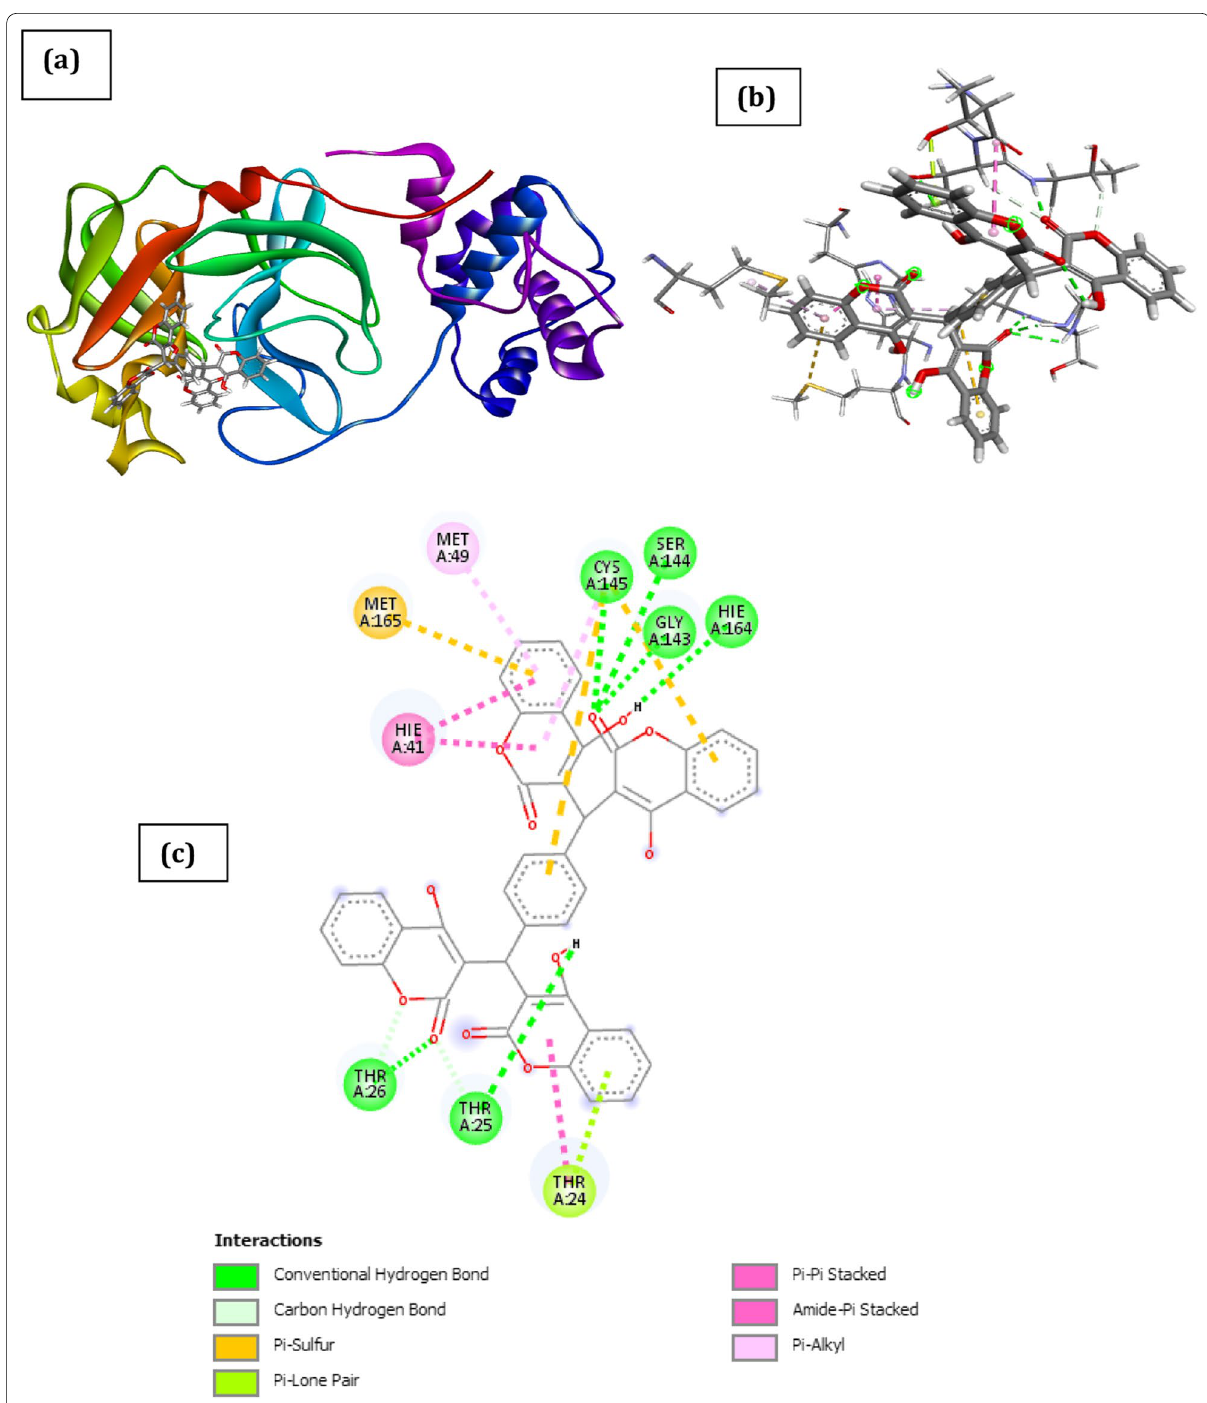
Fig. 2 Docked poses of SARS CoV 2 main protease (PDB ID: 6XBH) with inhibitor with Index number 331 (stick figure) a 3D view of docked pose of SARS CoV 2 Main Protease (PDB ID: 6XBH) with inhibitor with Index number 331; b 3D view of inhibitor with Index number 331 with surrounding amino acids of 6XBH; c 2D view of interaction type of inhibitor with Index number 331 with surrounding amino acids of